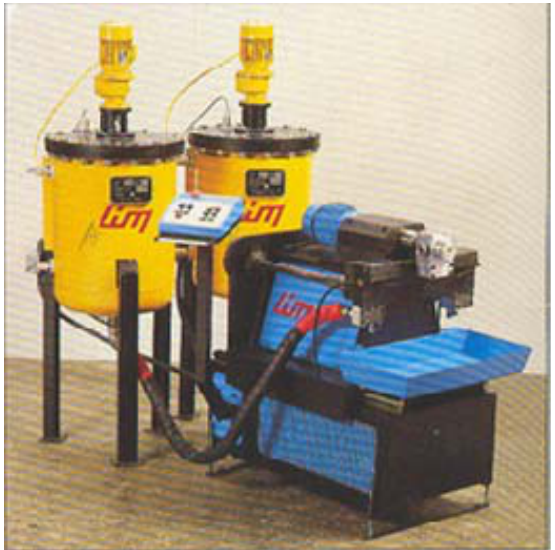
Figure 10 – One of the LIM technology machines Рис . 10 – Машина применяемая в LIM технологии Слика 10 – Једна од машина за ЛИМ